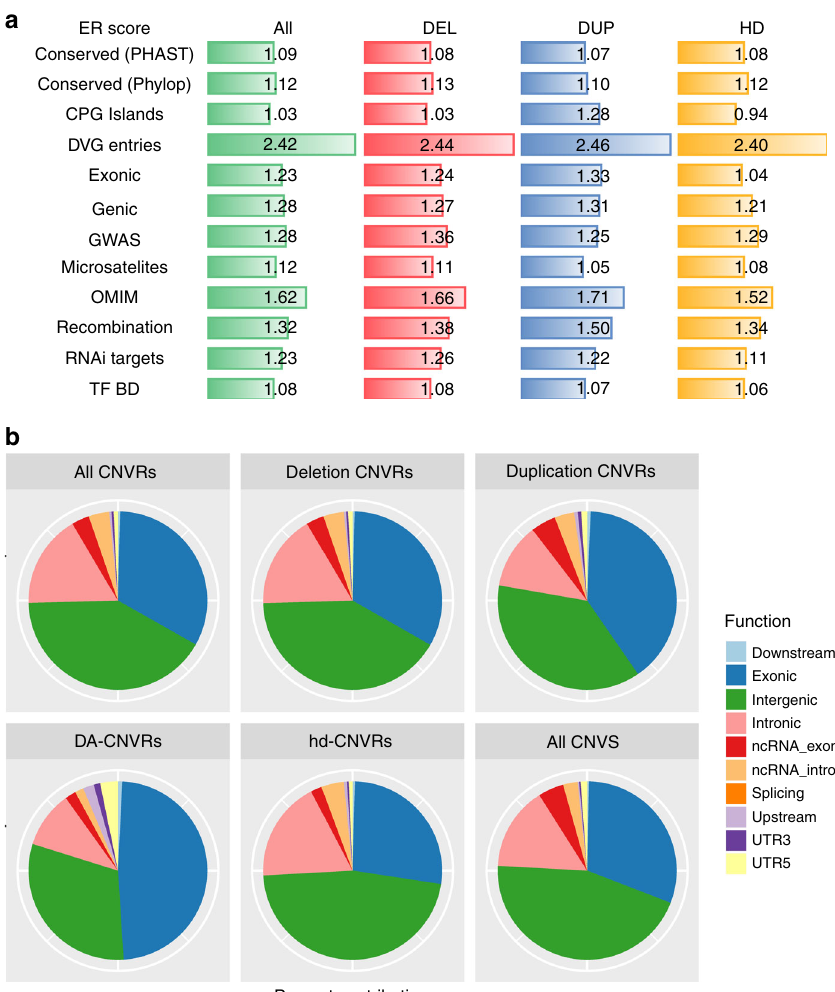
Fig. 2 Functional enrichment analysis. a Relative enrichment ratios for mapping of a CNV to a locus annotated as each of the given categories. ER was calculated based on 10,000 repeated simulations for each category/CNVR combo (see Methods). Regions of the genome bearing CNVs were signi fi cantly more likely to map to loci that are gene-bearing (Genic regions), exonic, or conserved (PHAST or PhyloP), and are enriched for functional loci, including miRNA targets (RNAi), CpG islands (CpG), microsatellites, recombination hotspots (Recombination), transcription factor-binding sites (TF BD), and were more likely to map to regions previous CNVs have been reported in the Database for Genomic Variants (DGV). ER enrichment ratio; DUP duplication; DEL deletion; HD homozygous deletion. The enrichment results are reported separately for “ ALL ” CNVRs and CNVRs optimized for Dup, Del, or HD CNVs. b Contribution of CNVRs with different transcriptional impact as annotated by Ensemble Variant Effect Predictor for the nearest gene, respectively, for all CNVRs, deletion CNVRs, duplication CNVRs, disease-associated CNVRs, homozygous deletion CNVRs, and all CNVs identi fi